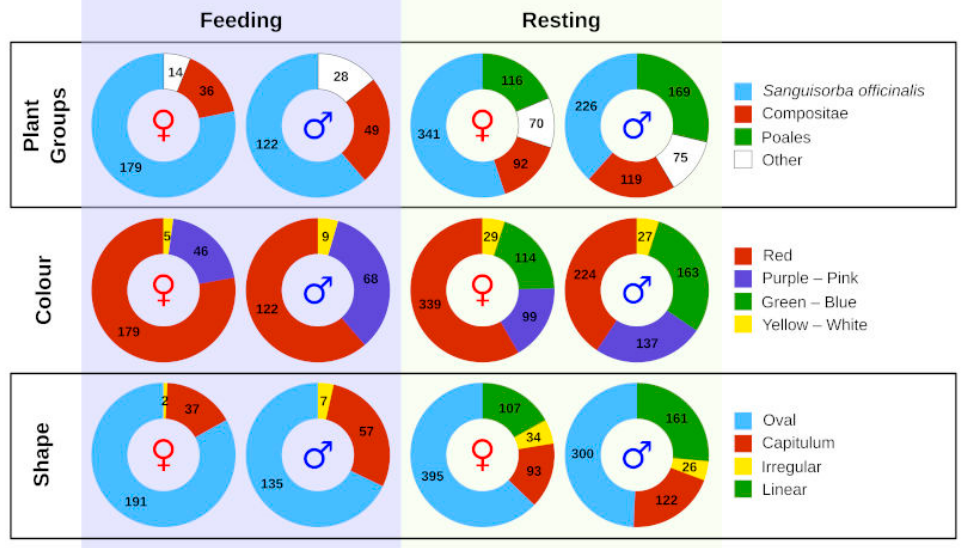
Figure 2. Resource use by Phengaris teleius butterflies for feeding and resting as recorded during a mark–release–recapture study. The plants used are classified according to species groups, flower colour and shape. The numbers within the graph represent sample sizes, while symbols denote females ( ♀ ) and males ( ♂ ).